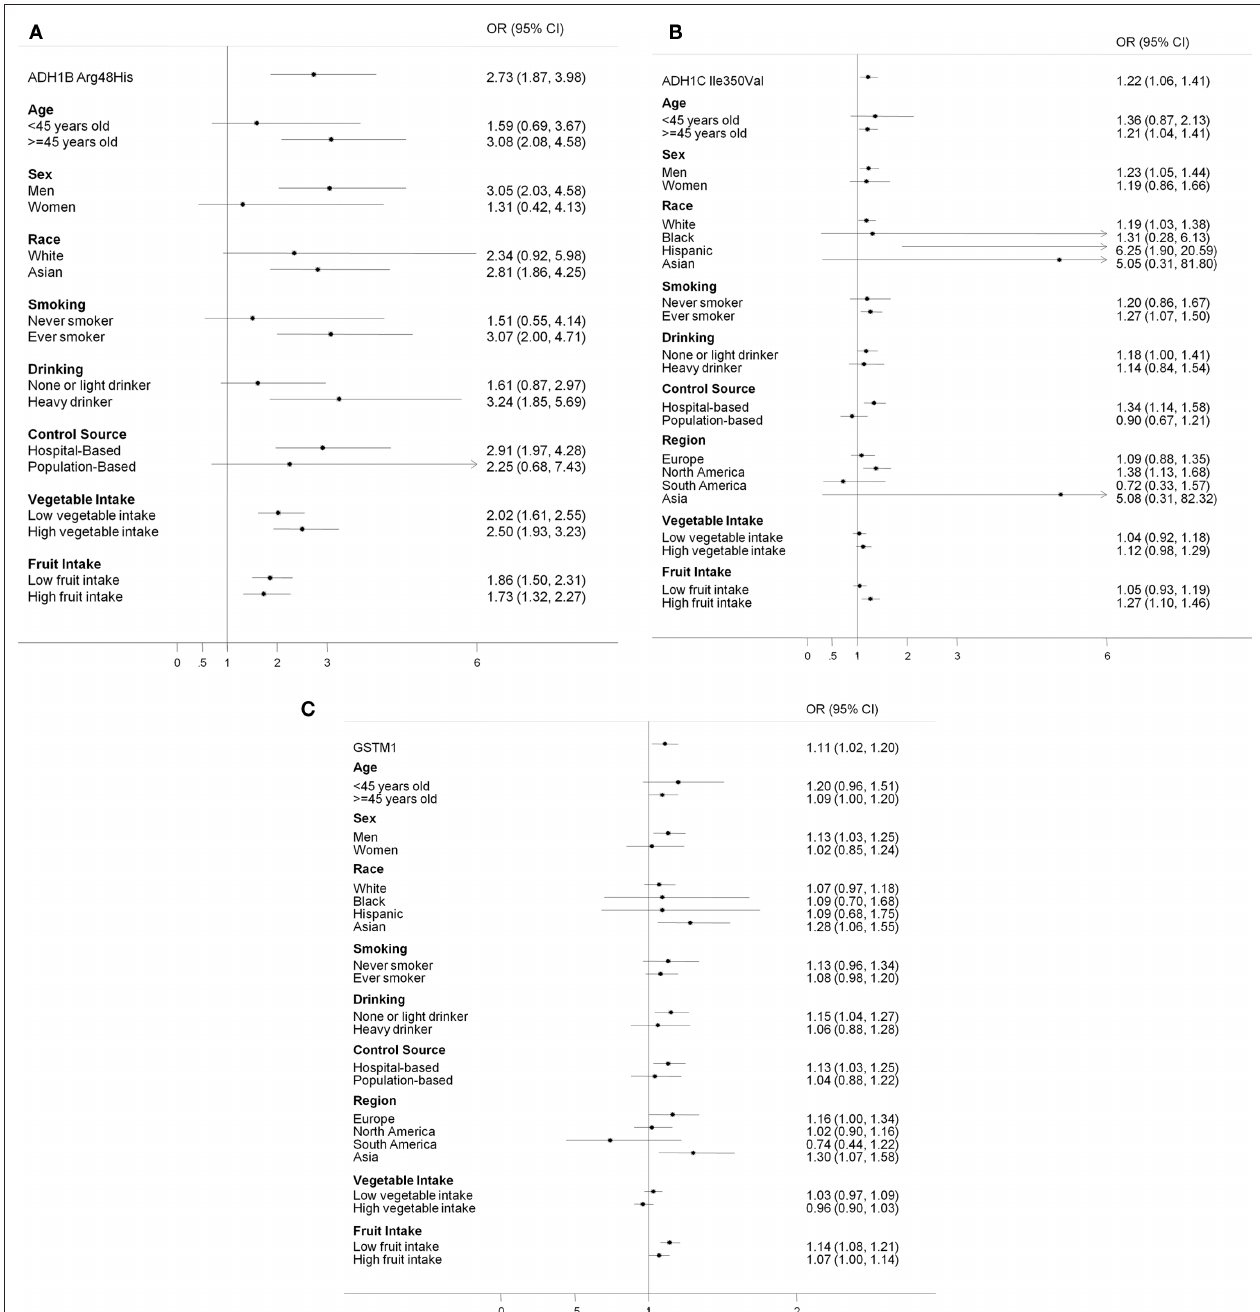
FIguRE 1 | Stratified analysis for selected SNPs: (A) ADH1B Arg48His; His/His vs. Arg/Arg (B) ADH1C Ile350Val: Val/Val vs. Ile/Ile; (C) gSTM1 null